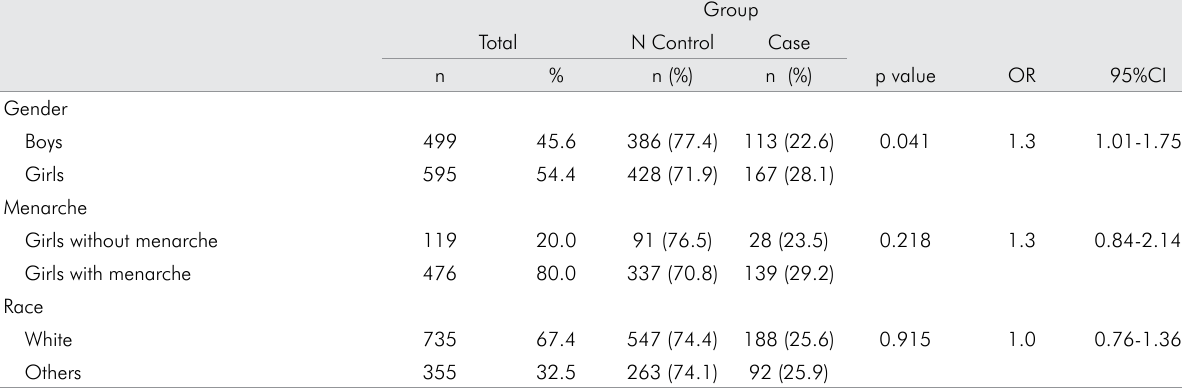
Table 1. Demographic characteristics of the sample and their association with painful